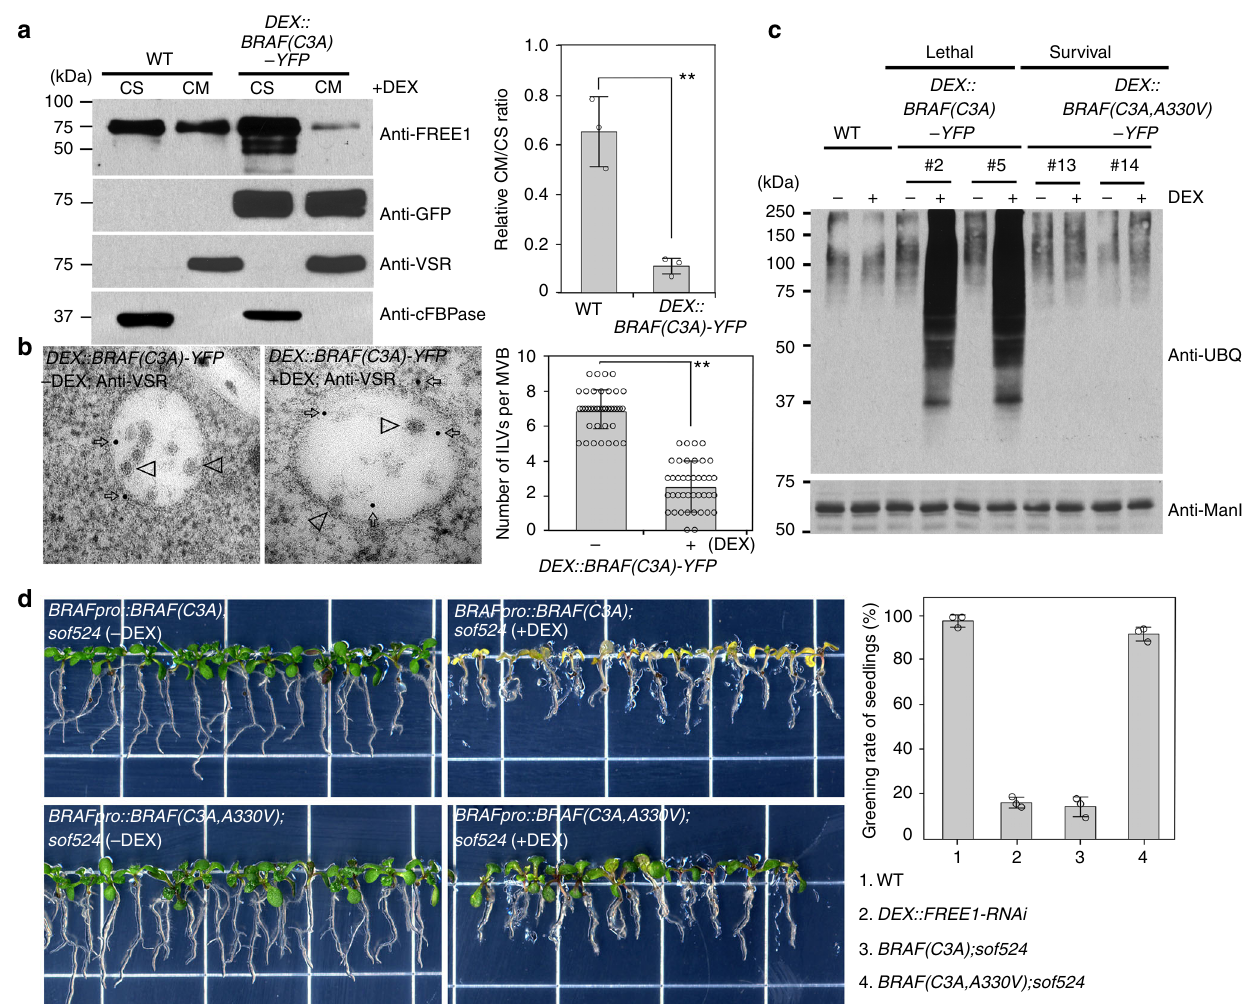
Fig. 7 BRAF(C3A)-overexpressing mutant causes defects in membrane proteins ’ vacuolar sorting. a Immunoblot analysis of FREE1 membrane association in WT and DEX::BRAF(C3A)-YFP plants after DEX induction. The FREE1 intensity was normalized by the loading control of anti-VSR as cell membrane (CM) fraction and anti-cFBPase as cell soluble (CS) fraction, and the CM/CS ratio of FREE1 in indicated genotype seedlings was quanti fi ed on the right. Error bars are the S.D. from three independent experiments. ** P < 0.01 in Student ’ s t -test. b Electron micrographs of ILV formation in MVBs. Ultrathin sections were prepared from HPF/FS samples of indicated genotype plant roots without ( − ) or with ( + ) DEX induction, followed by immunogold labeling using VSR antibodies. The number of ILVs per MVB was statistically analyzed on 40 MVBs recognized by VSR antibodies. Error bars are the S.D. ** P < 0.01 in Student ’ s t -test. Scale bar, 100 nm. c Immunoblots of membrane protein extracts from 7-day-old seedlings using anti-UBQ or anti-ManI. Note the accumulation of ubiquitin conjugates in DEX::BRAF(C3A)-YFP under DEX induction. d Complementation of sof524 with BRAFpro::BRAF(C3A) or BRAFpro:: BRAF(C3A,A330V) . The T1 generation-transformed seedlings were screened on MS with antibiotics for 5 days, and the seedlings were then transferred to MS medium without ( − ) or with ( + ) DEX for 7 days. Greening rate of seedlings after DEX treatment was quanti fi ed on the right. Error bars are the S.D. from three independent experiments. Scale bar, 1 cm Next, we used the de-acylated BRAF(C3A) overexpression YFP punctae represent mostly MVB/PVCs. By contrast, BRAF mutant to investigate the seedling phenotype and possible effect (C3A,A330V)-YFP signals were mainly distributed throughout on FREE1 membrane association. We failed to obtain strong the cytosol (Fig. 6d). To further identify FREE1 membrane fl uorescence signals with the UBQ10pro::BRAF(C3A)-YFP trans- distribution in the BRAF(C3A)-YFP-overexpressing plants, CS genic line, suggesting that overexpression of BRAF(C3A) could and CM fractions from WT and BRAF(C3A)-YFP plants were lead to lethality during vegetative plant growth. Indeed, DEX:: subjected to immunoblotting analysis with anti-FREE1 or anti- BRAF(C3A)-YFP transgenic lines under DEX treatment showed a BRAF. Interestingly, compared to the WT, an increased amount seedling lethal phenotype, but not with the lines expressing DEX:: of FREE1 was found to distribute in the CS fraction with less BRAF(C3A,A330V)-YFP , which harbors the sof524 mutation FREE1 in the CM fraction in plants expressing the BRAF(C3A)- (Fig. 6c and Supplementary Fig. 9A). BRAF(C3A)-YFP accumu- YFP (Fig. 7a). We hypothesize that decrease of the FREE1 on lated in the intracellular compartments in expressing cells membrane in BRAF(C3A)-YFP mutant would result in failure of (Fig. 6d), which mainly colocalized with the MVB/PVC marker ILV formation and consequently accumulation of ubiquitinated mCherry-Rha1, and partially associated with the Golgi marker membrane cargo. We therefore investigated MVB/PVC morphol- mCherry-SYP32, but separated from the TGN/EE marker VHA- ogy at the ultrastructural level. The anti-VSR usually labeled a1-RFP (Supplementary Fig. 9B – D), indicating that BRAF(C3A)- MVB/PVCs with a reduced number of ILVs per MVB section in NATURE COMMUNICATIONS| (2018) 9:3784 |DOI: